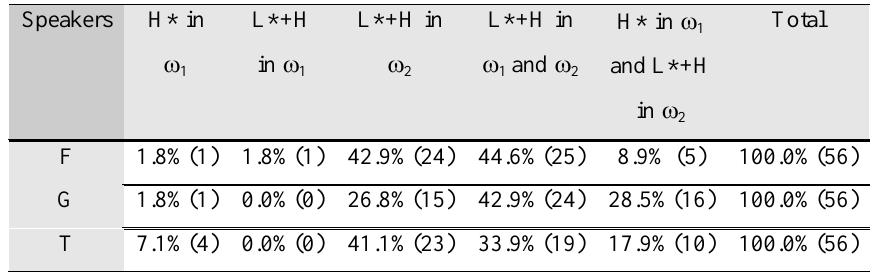
Table II. Tonal events associated with each  of the I-initial branching 